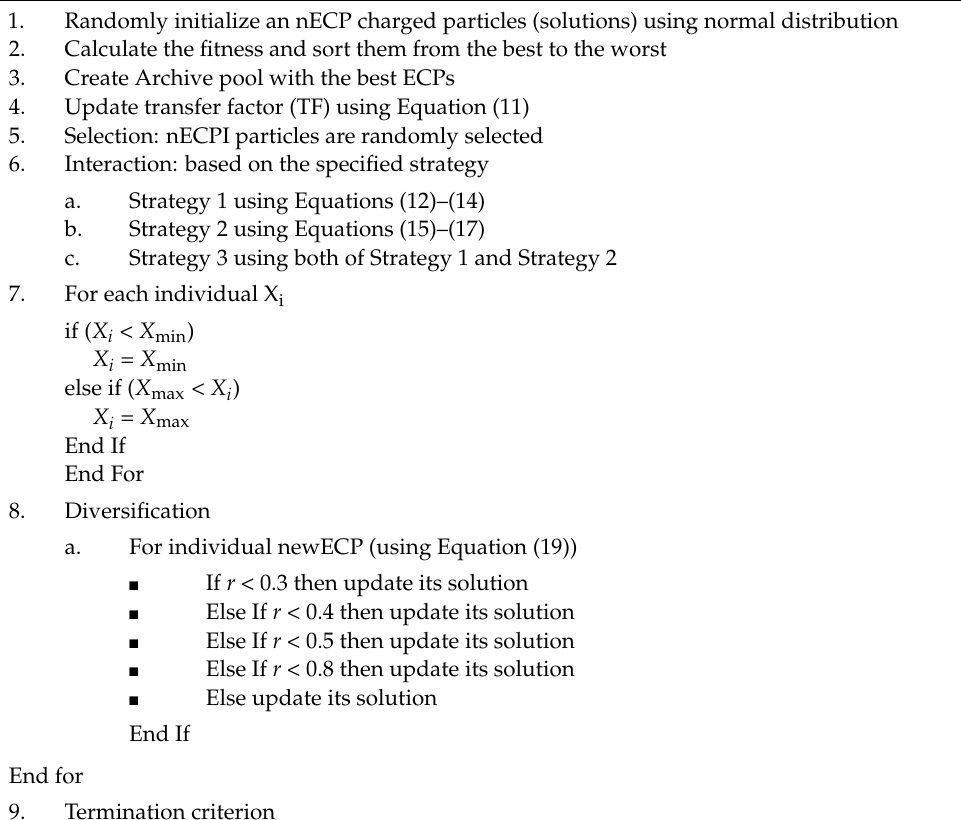
Algorithm 1: Pseudo-code of the MECPO